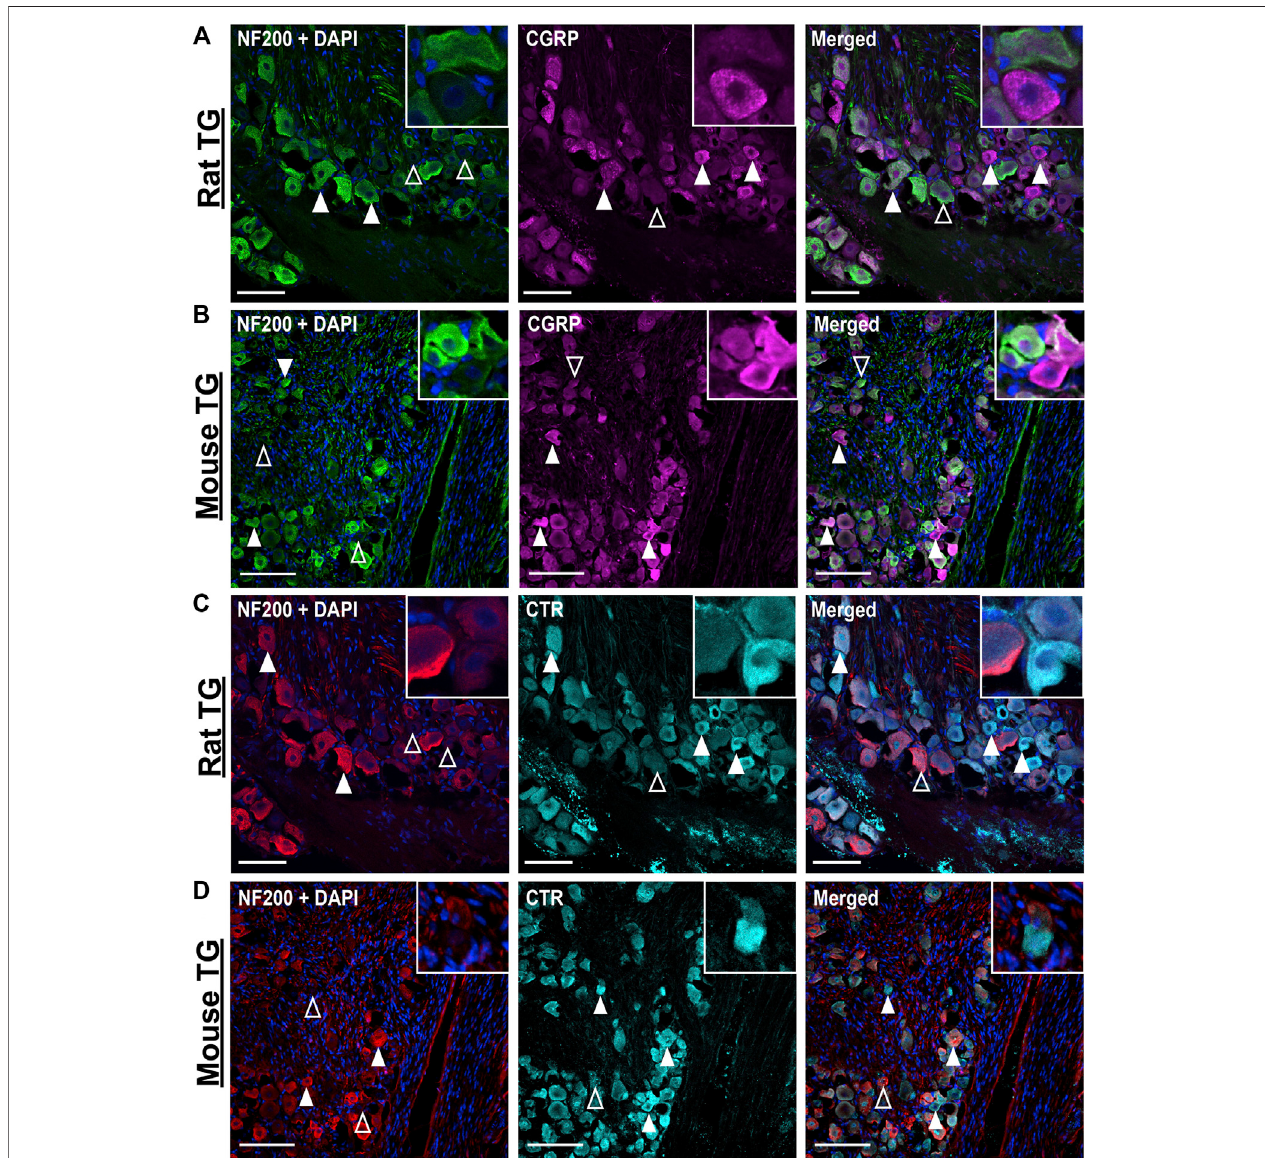
FIGURE 2 | Immunohistochemical localization of CGRP (pAb36001, 10 µg/ml) or CTR (pAb188, 10 or 20 µg/ml) individually with NF200 (3 µg/ml) in adult rat and mouse TG. (A) CGRP and NF200 in rat (B) CGRP and NF200 in mouse (C) CTR and NF200 in rat and (D) CTR and NF200 in mouse. Filled white arrowheads indicate examples of positive staining; empty arrowheads indicate examples of an absence of staining. Image brightness and contrast were adjusted for presentation purposes and merged in FIJI. Scale bar = 100 μ m. Images are representative of six rats and six mice (three male and three female).